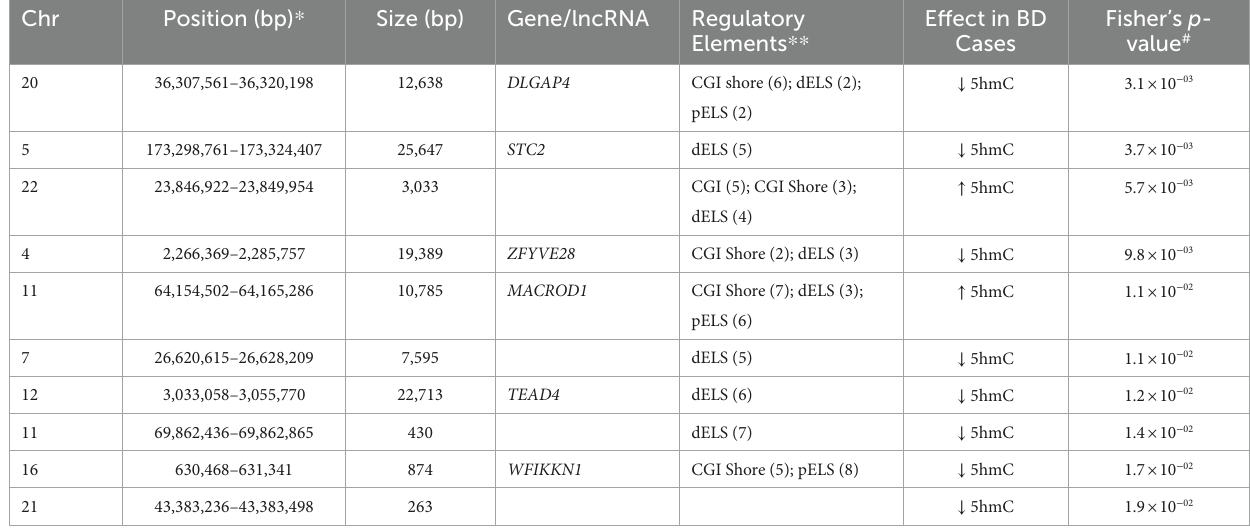
TABLE 5 Top-10 differential hydroxymethylation regions (DhMRs) between BD cases and sibs for NSC cell